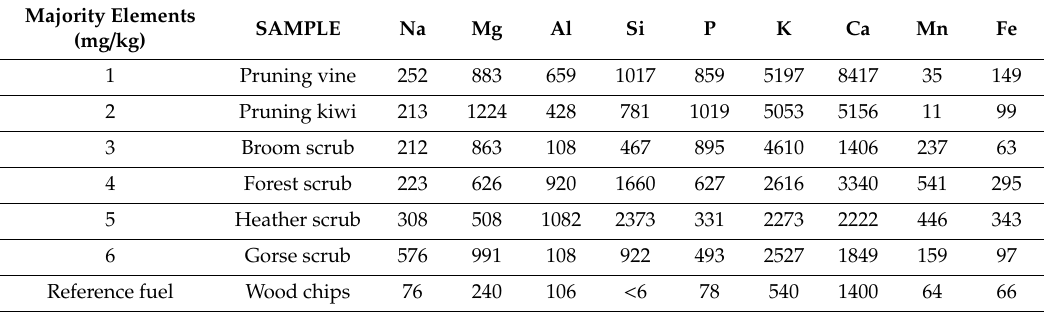
Table 4. Majority